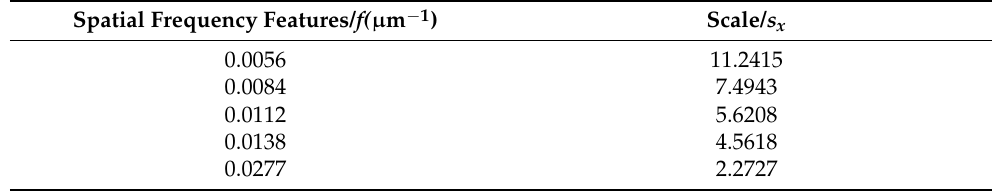
Table 3. CWT calculation parameters of the spatial frequency features in the X direction.